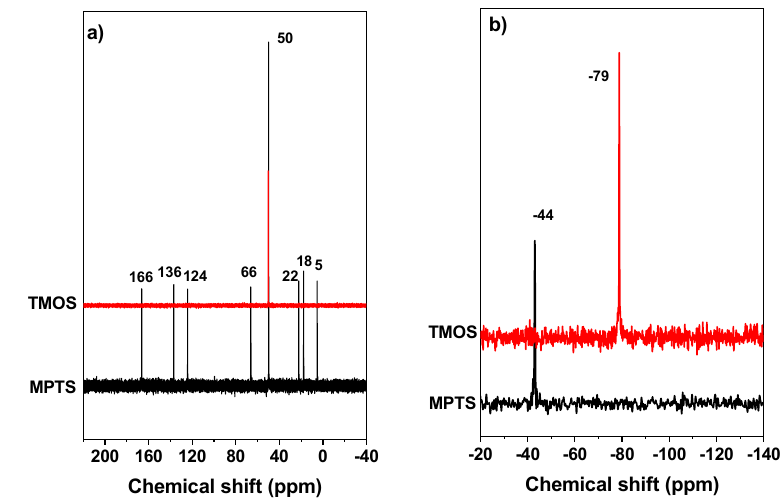
Figure 1. 13 C ( a ) and ( b ) 29 Si NMR spectra of two pure reagents.